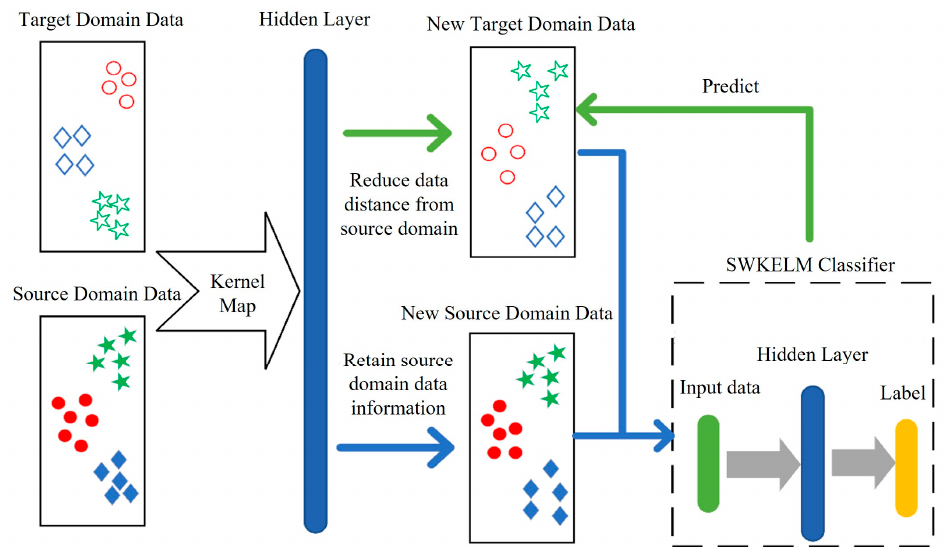
Figure 1. DTSWKELM algorithm flow chart.